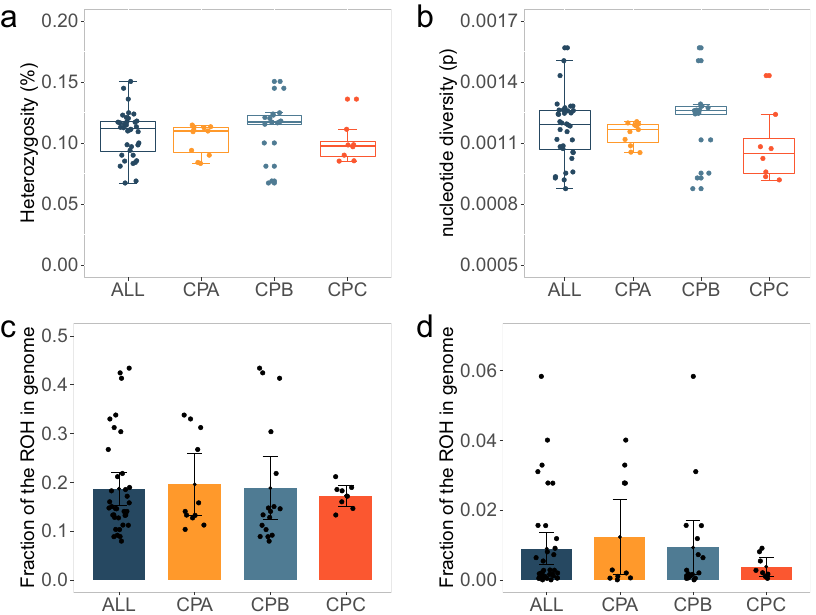
Fig. 4 Genetic diversity and ROH distribution in the Chinese pangolin genome. a Heterozygosity in each population. b Nucleotide diversity in each population. Error bars show range of values within 1.5 times the interquartile range. c , d Fraction of run of homozygosity (ROH) in the genome of each population, including the medium ( c : 100kb – 1Mb) and long ( d : >1Mb) ROHs. Data are presented as mean±SD. ALL: n = 36. CPA: n = 11. CPB: n = 17. CPC: n =